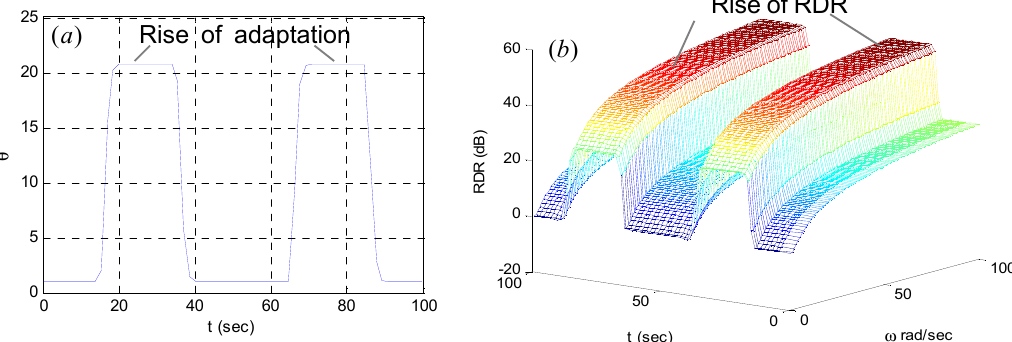
Figure 11. ( a ) Evolution of adaptation gain θ of the ML-MR PID-I control structure. ( b ) Adaptive modification of the RDR spectrum of the C θ ( s ) controller for disturbance rejection.